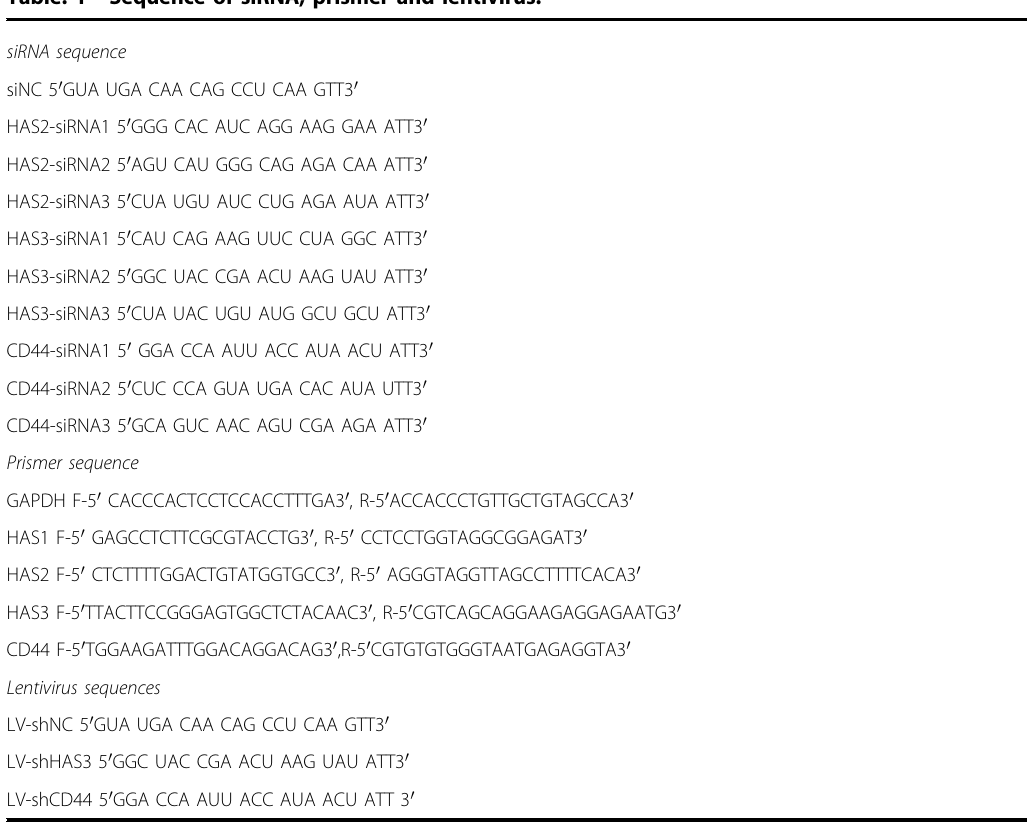
Table 1. Western blot analysis Protein samples were extracted from glioma cell lines/ glioma tissues. Protein samples were separated on 12.5% SDS-PAGE gels and transferred to PVDF membranes.